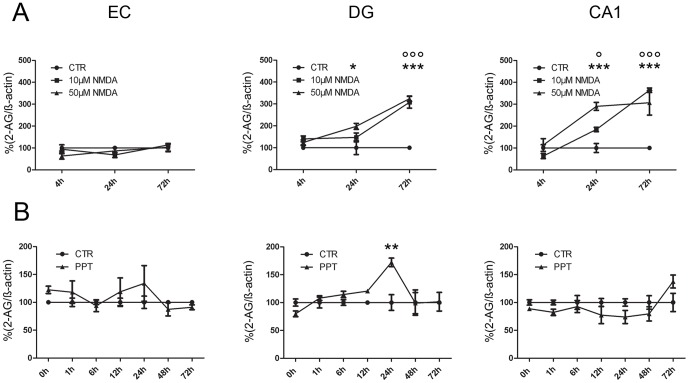
Intrinsic 2-AG regulation after neuronal damage - excitotoxic NMDA lesion and PPT.2-AG levels in EC, DG and the CA1 region normalized against ß-actin immunosignals. Control condition (CTR) of each time-point was set as 100% (black cycles). (A) 2-AG levels after application of 10 µM and 50 µM NMDA. In the DG an increase in 2-AG was seen 24 hpl after 50 µM of NMDA. After 72 hpl 2-AG levels were elevated significantly independent of the NMDA concentration. In the CA1 region increased 2-AG levels were measured 24 and 72 hpl after 10 µM and 50 µM NMDA treatment (n = 3, °sig. for 10 µM NMDA, *sig. for 50 µM NMDA, °p<0.05, °°° or ***p<0.001). (B) 2-AG levels after PPT. In EC 2-AG levels (gray circles) did show a non significant alteration at 1 hpl in comparison to the respective CTR. In the DG, 2-AG was significantly increased 24 hpl (n = 4, **p<0.01) and in the CA1 region 2-AG levels did not differ significantly from CTR values (p>0.05).